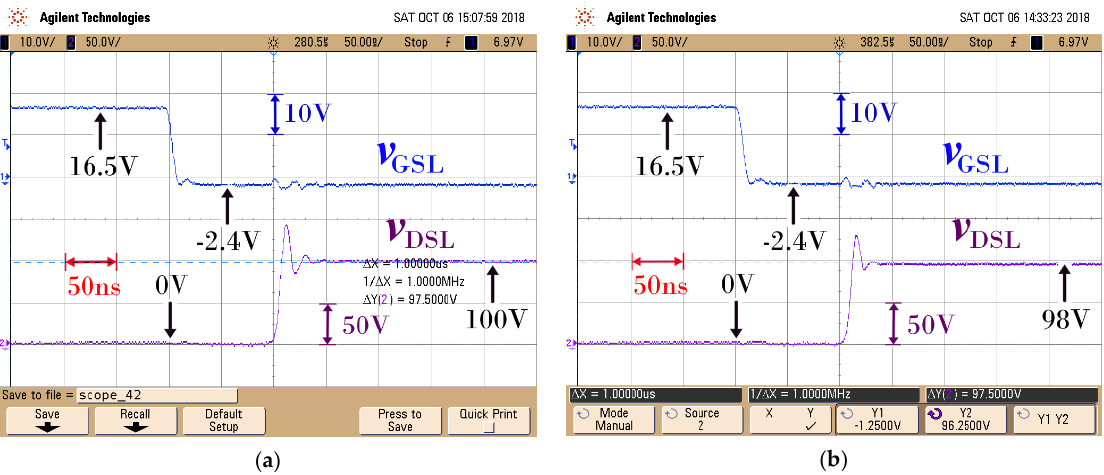
Figure 15. Experimental turning-on waveforms with RC snubber using ( a ) C SBR = 440 pF and R SBR = 10 Ω, and ( b ) C SBR = 1 nF and R SBR = 10 Ω.